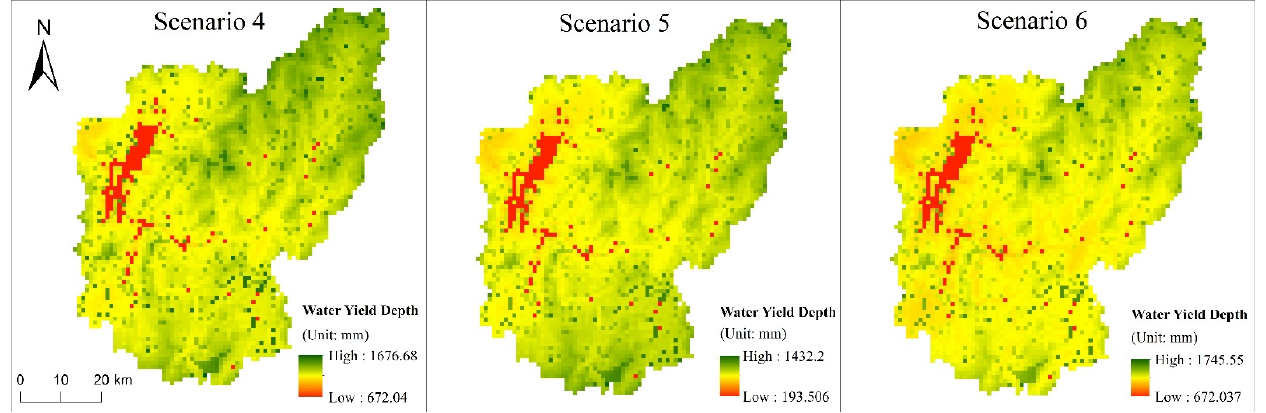
Figure 7. Water yield pattern of Dongjiang Lake Basin with climate unchanged.